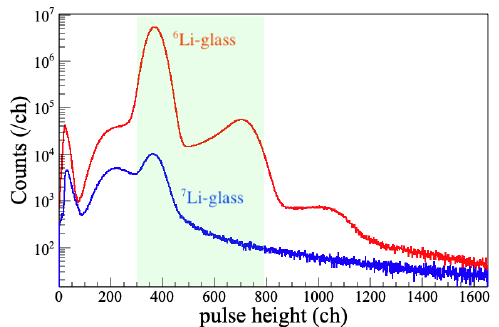
Figure 1. Pulse height spectra of the 6 Li- and 7 Li-glass detectors. The gated region shown by green is used in the present analysis.